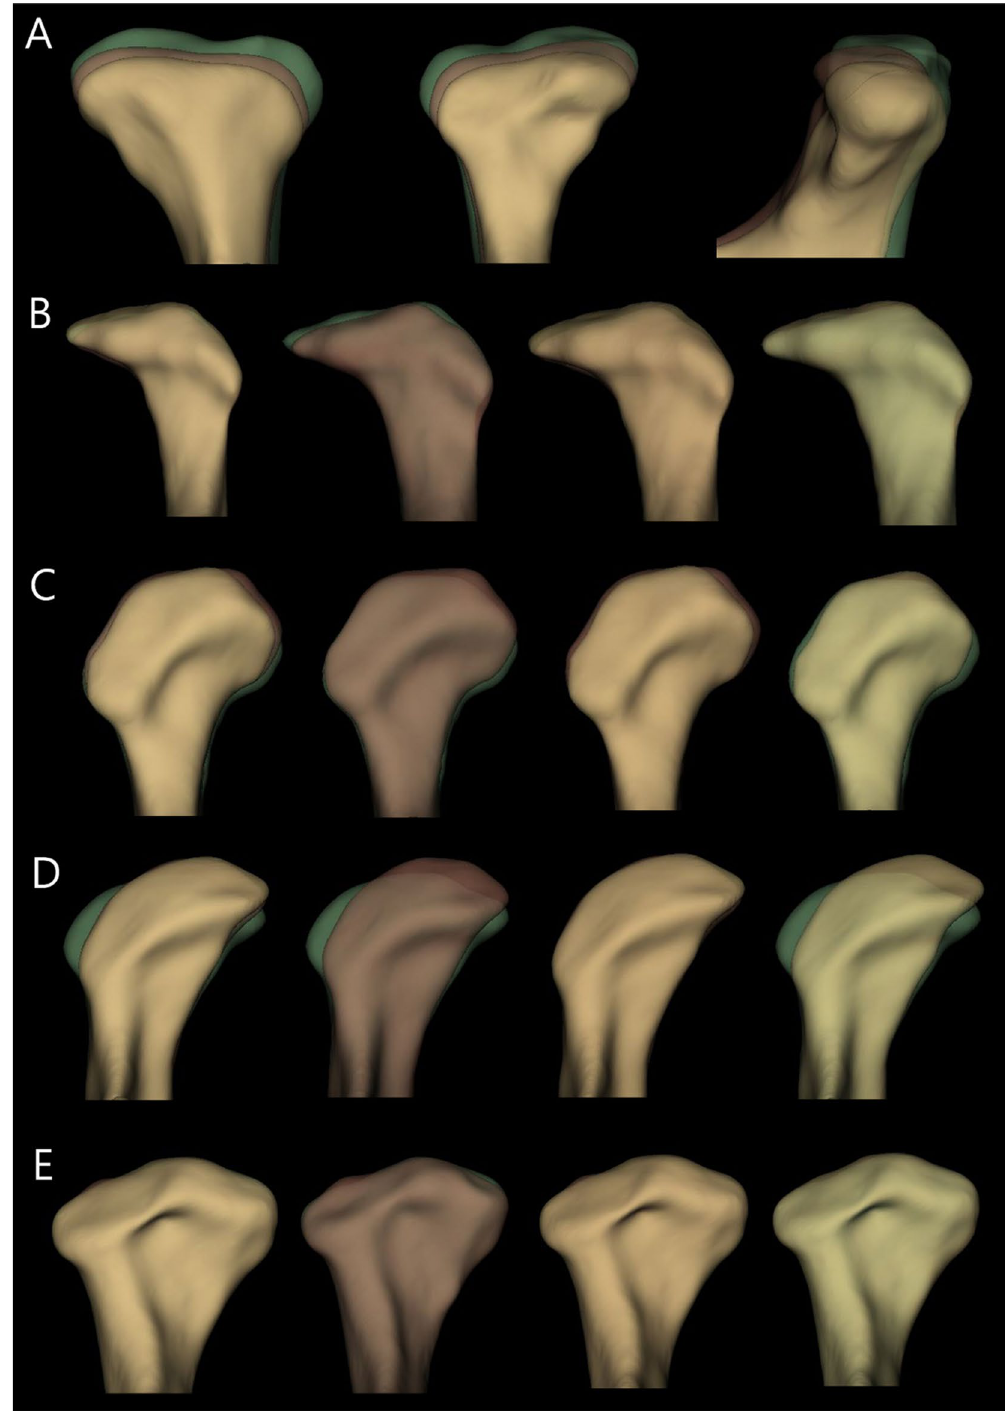
Figure 3. Mandibular condyles showing resorption and apposition changes in the superior part ( A ) Resorption → Resorption ( B ) Resorption → Apposition ( C ) Apposition → Resorption ( D ) Apposition → Apposition ( E ) No change. Green: T 0 , red: T 1 , and yellow: T 2 . T 0 , initial timepoint; T 1 , middle timepoint;